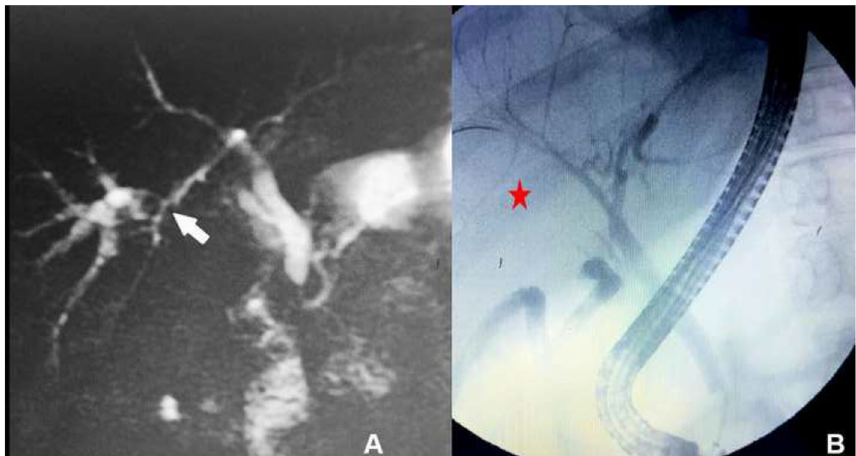
Fig. 10 3D-MRCP ( a ) post-cholecystectomy with interrupted aberrant right posterior hepatic bile duct. A finding that is easily demonstrated as the ligated dilated right posterior segmental duct is well visualized “white arrow”. Strasberg Type B bile duct injury. ERCP image ( b ) shows a filling defect in the right posterior sectoral system (Red asterisk*)